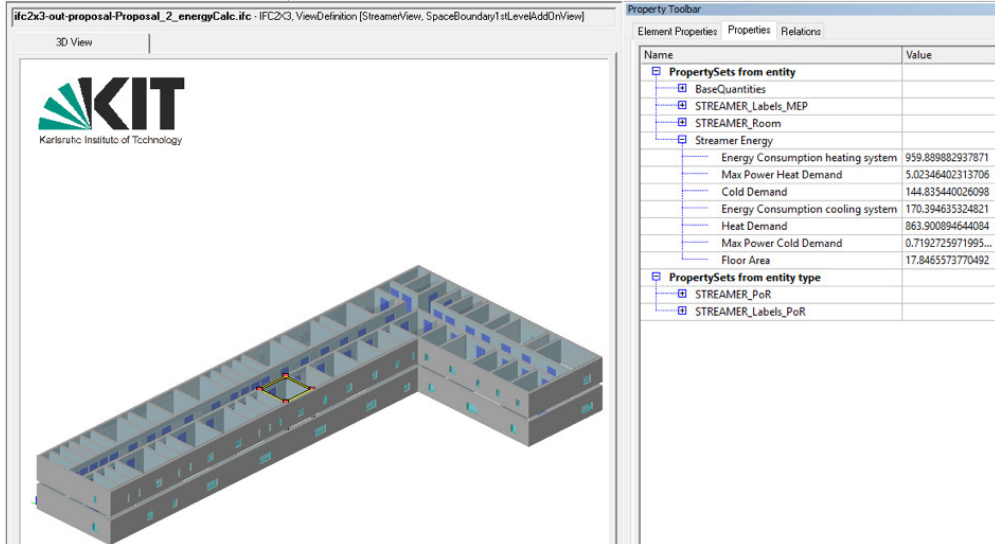
Figure 8. Energy simulation results at the space level integrated into BIM.